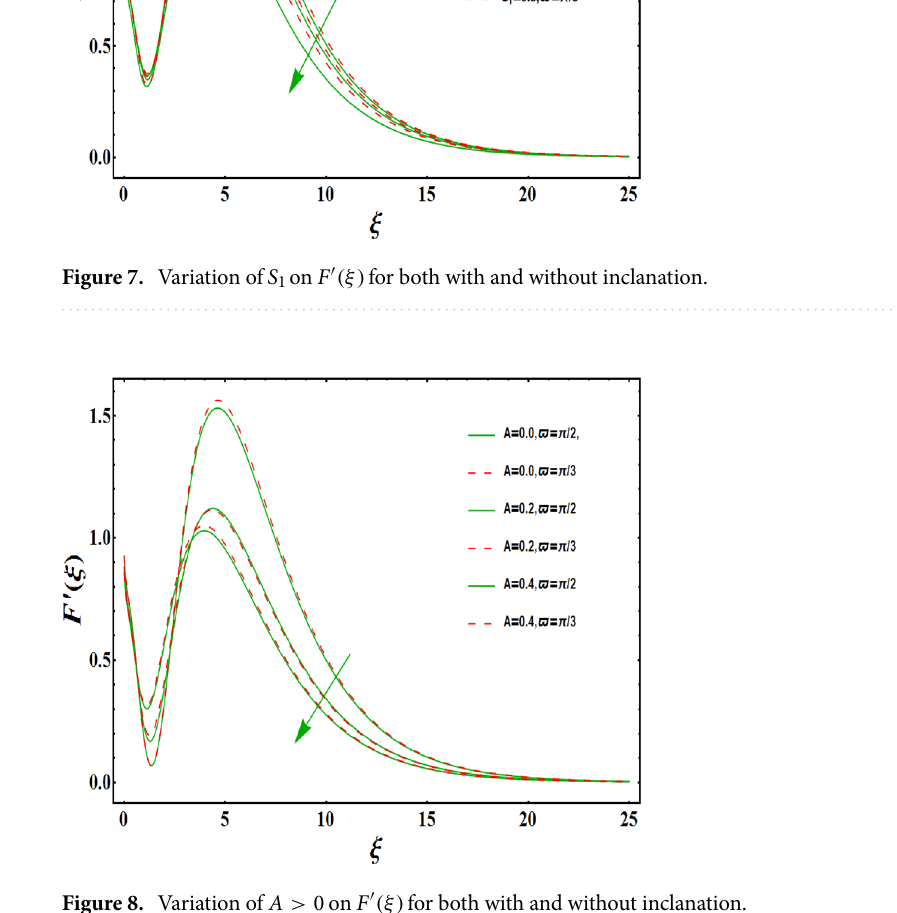
Figure 8. Variation of A > 0 on F ′ (ξ) for both with and without